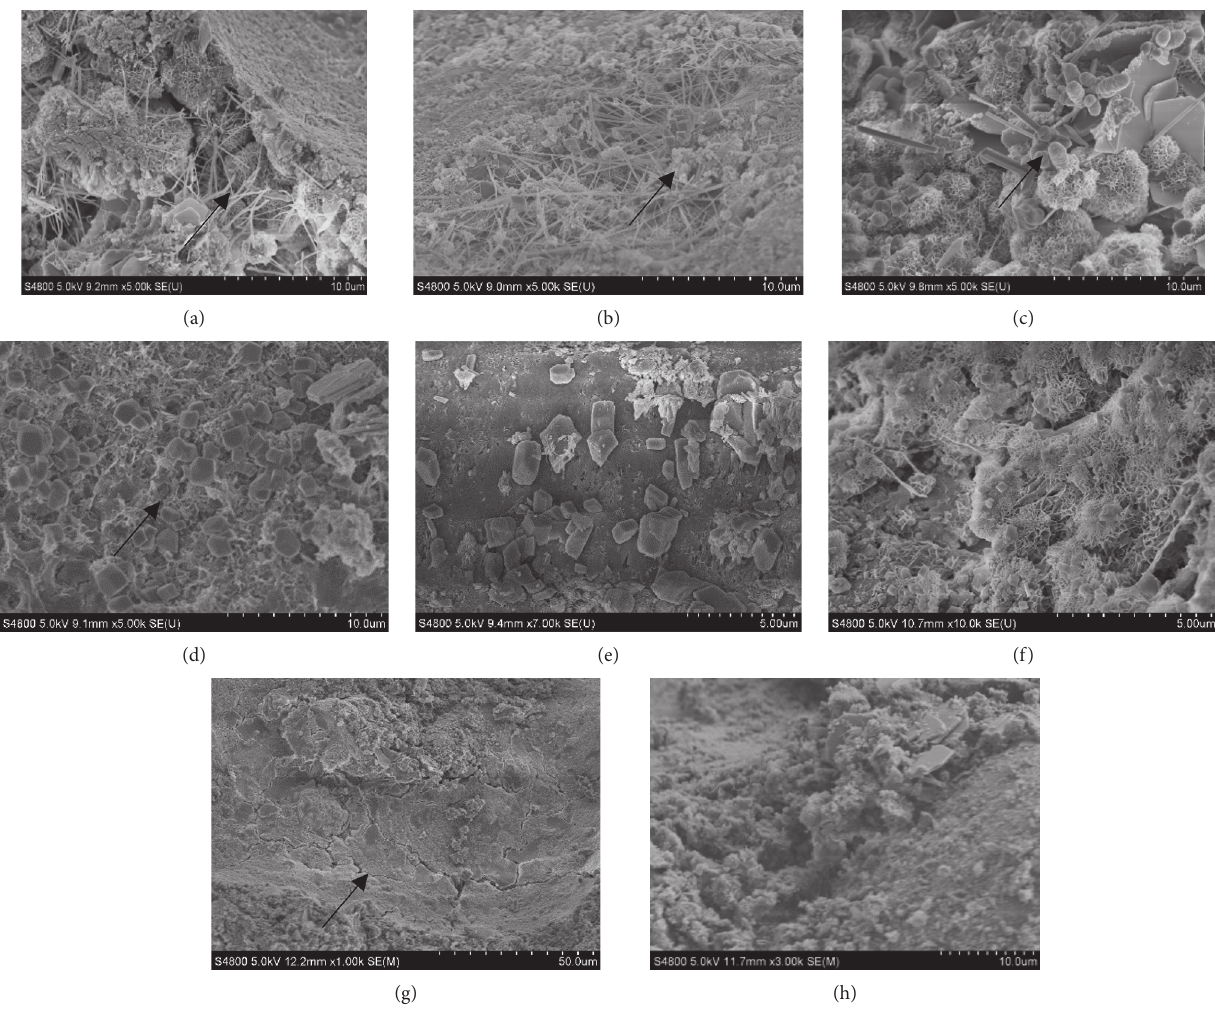
Figure 6: SEM images of cement-stabilized sand in different curing schemes. (a) 7d-SS8%; (b) 28d-SS8%; (c) 60d-SS8%; (d) 28d-SS7%; (e) 28d-FS7%; (f) 28d-FF7%; (g) 60d-FS8%; (h)